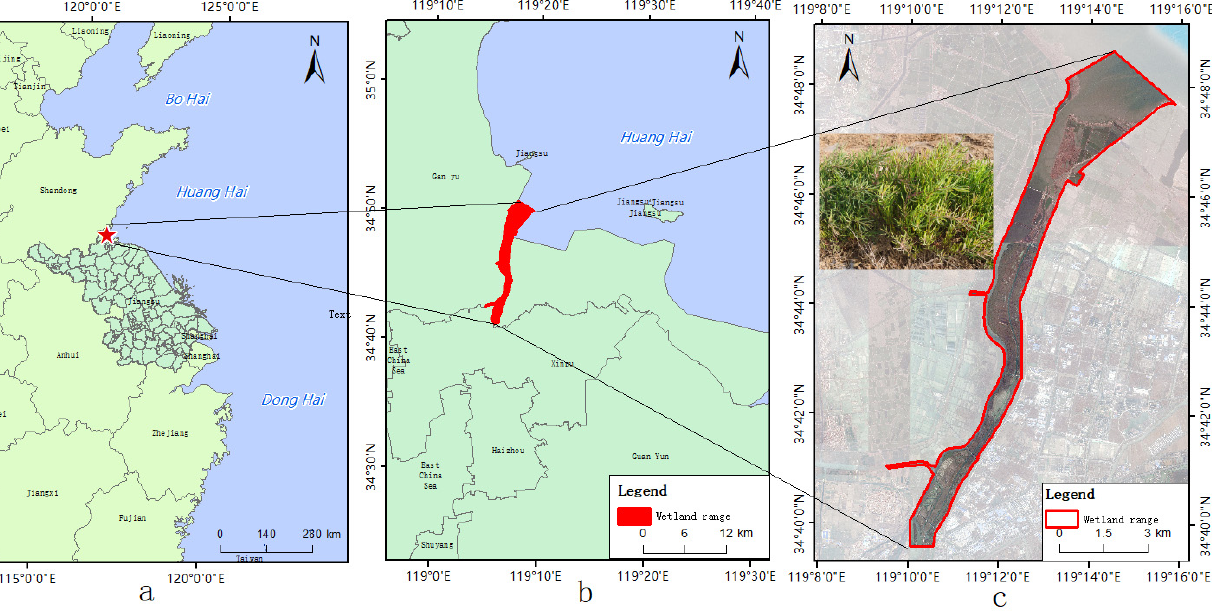
Figure 1. Location of the study area. (( a ) represents the location of the study area in China, ( b ) represents the location of the study area in Lianyungang City, ( c ) represents the specific location of the study area).